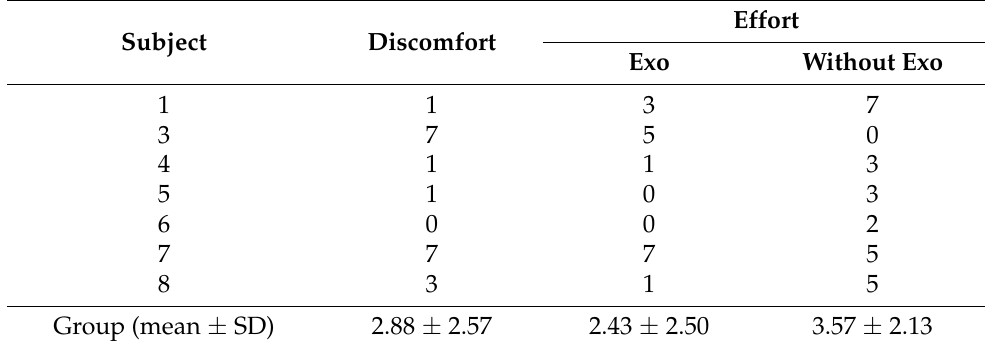
Table 2. Perception of the task (discomfort and effort), with and without exoskeleton, according to each